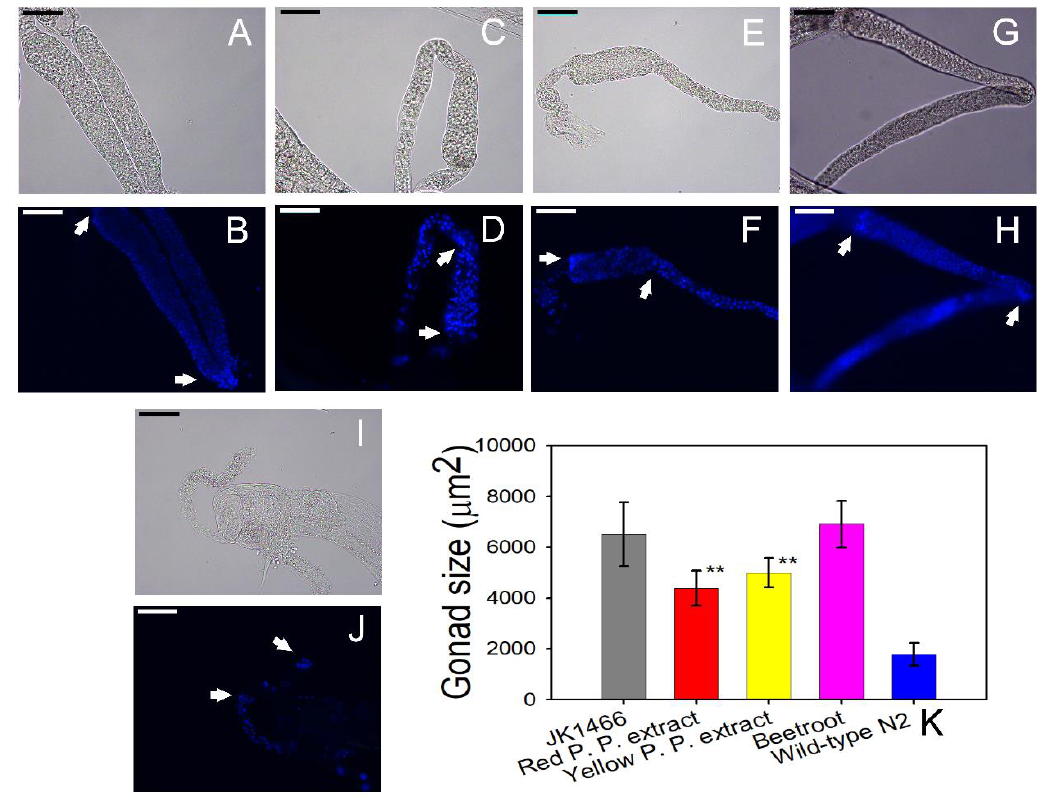
Figure 2. Size and morphology comparison of gld-1 mutants’ gonads with and without treatment with betalain-containing extracts and the wild-type animal. Representative images of BF and DAPI-stained of dissected gonads from glp-1 (q485) animals treated with natural extracts (at 1% w/v ) and wild-type animals are shown. Scale bar, 50 μm. Dissected gonads images from gld-1 mutants without treatment (positive control) in BF ( A ) and DAPI-stained ( B ). Dissected gonads images from gld-1 mutants treated with red prickly pear extract in BF ( C ) and DAPI-stained ( D ), treated with yellow prickly pear extract in BF ( E ) and with DAPI-stained ( F ), and treated with beetroot extract in BF ( G ) and DAPI-stained ( H ). Dissected gonads images from wild-type N2 strain (negative control) are shown in BF ( I ) and DAPI-stained ( J ). Gonads from loop region to proximal region have been indicated with arrow marks. ( K ) Gonads size histograms (mean ± SEM) of wild-type (negative control) ( n = 17) and gld-1 mutants treated with red (n = 13) and yellow ( n = 13) prickly pears extracts and beetroot extract ( n = 18) and without treatment (positive control) ( n = 18). ** indicated p ≤ 0.05.